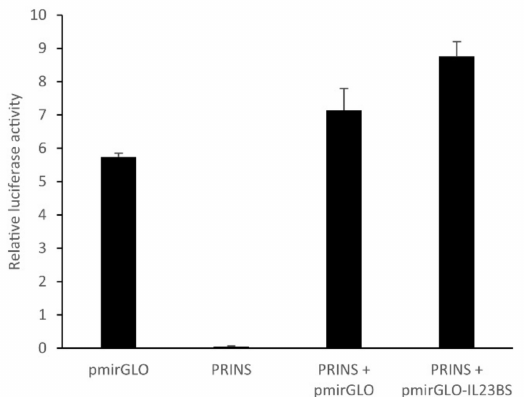
Figure 9. An in vitro binding assay revealed no interaction between the putative PRINS-interacting sequence on IL-23 and PRINS long non-coding RNA. Cells were transfected with PRINS pcDNA3.1 and pmirGLO plasmids as controls or co-transfected with the PRINS pcDNA3.1 plasmid in combina- tion with pmirGLO or pmirGLO-IL23BS vectors. The pGL4.75 [hRluc/CMV] plasmid (Promega) was used as internal control. Cells were harvested after 24 h, and luciferase activities in the lysates were measured using the Firefly and Renilla Dual Luciferase Assay Kit and SYNERGY/HTX Multi-Mode reader following the manufacturer’s instructions. The luciferase activity derived from the pmirGLO plasmid was normalized to the renilla luciferase activity. Results of a representative experiment are shown with three technical repetitions.